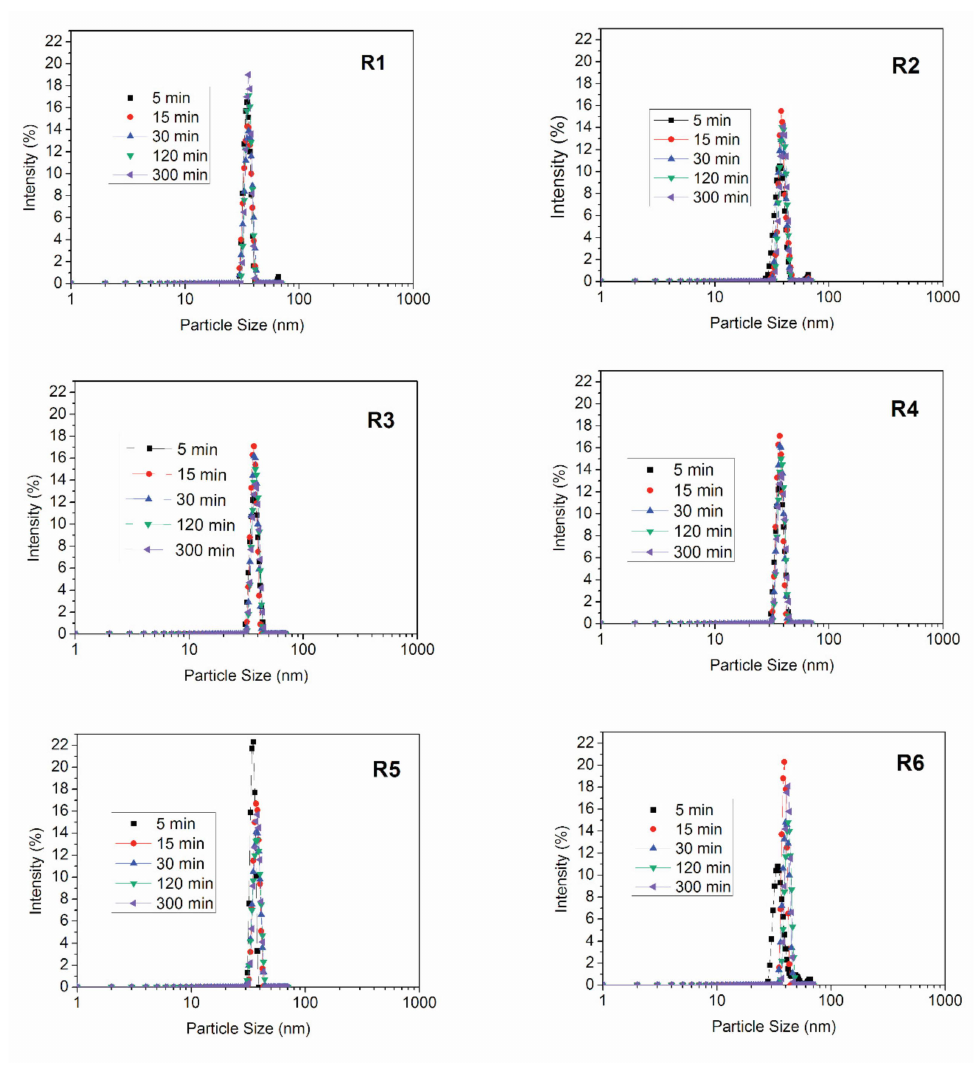
Figure 2. Evolution of particle size distributions for polymerization reactions shown in Table